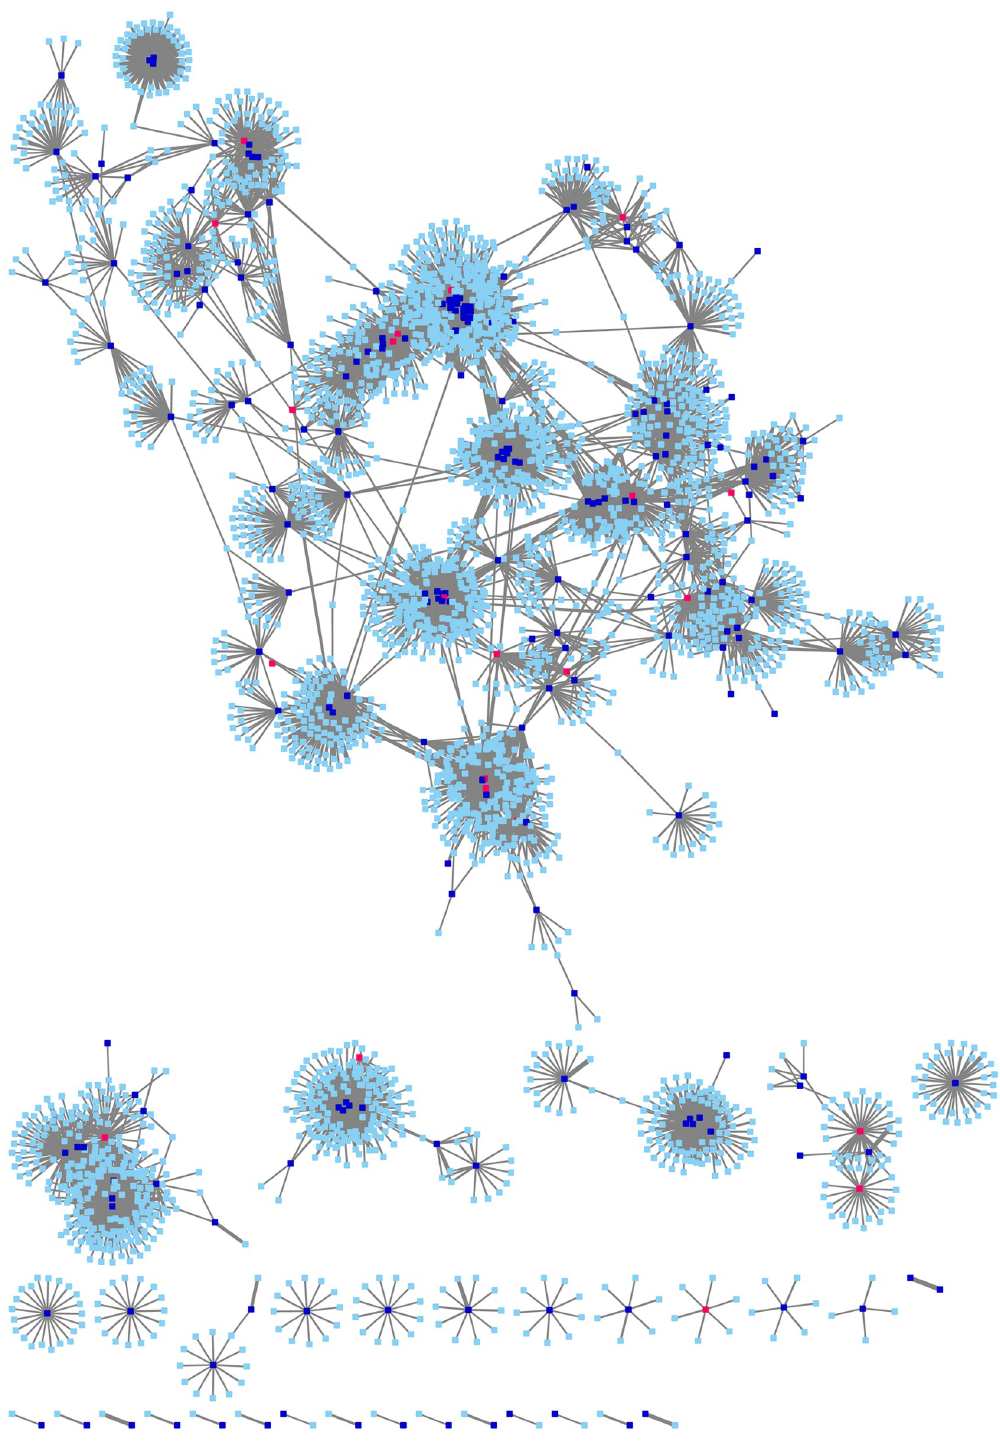
Fig 2. Social connections between methadone